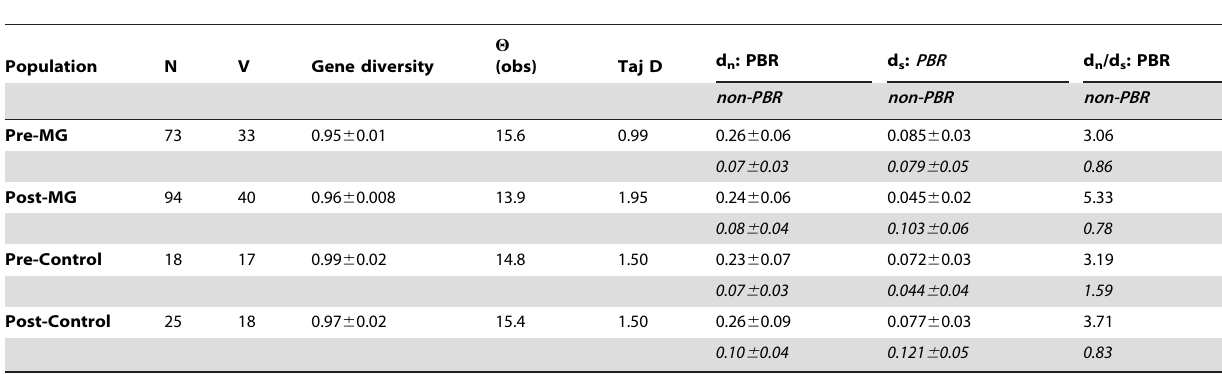
Table 3. MHC class II sequence diversity for MG-affected eastern populations and unaffected control populations across equivalent time periods.